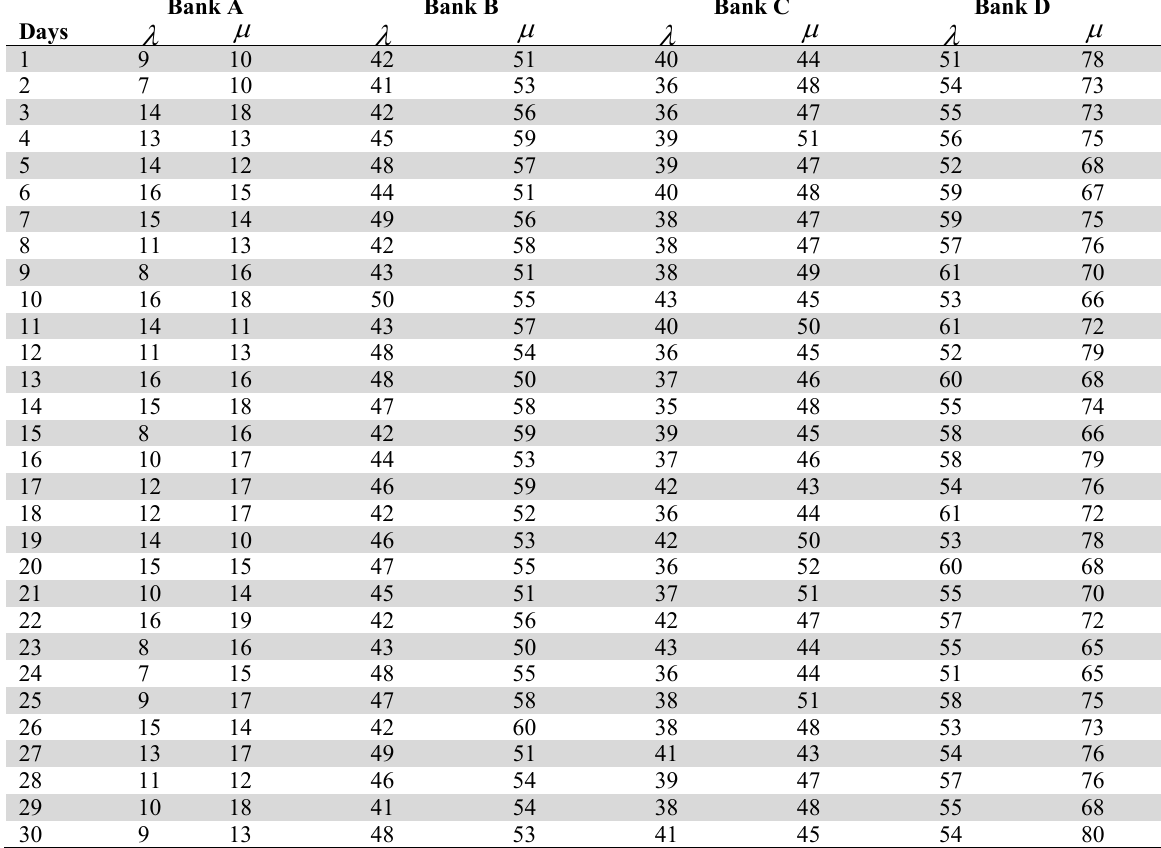
The arrival and service rates of each of the banks Bank A Bank B Bank Days